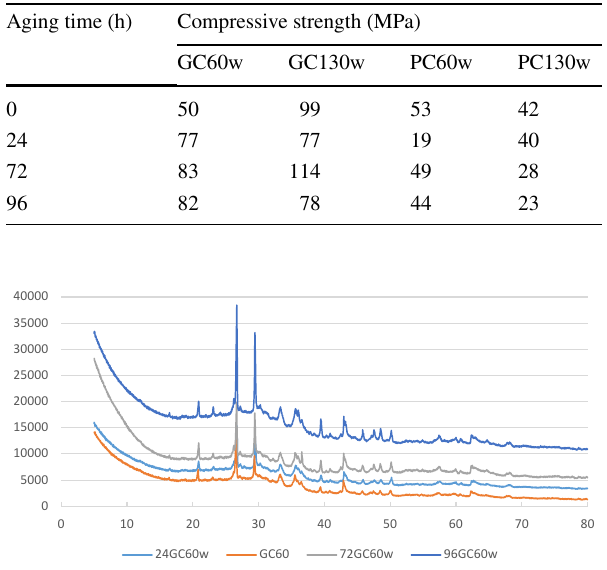
Fig. 1 XRD pattern before and after CO